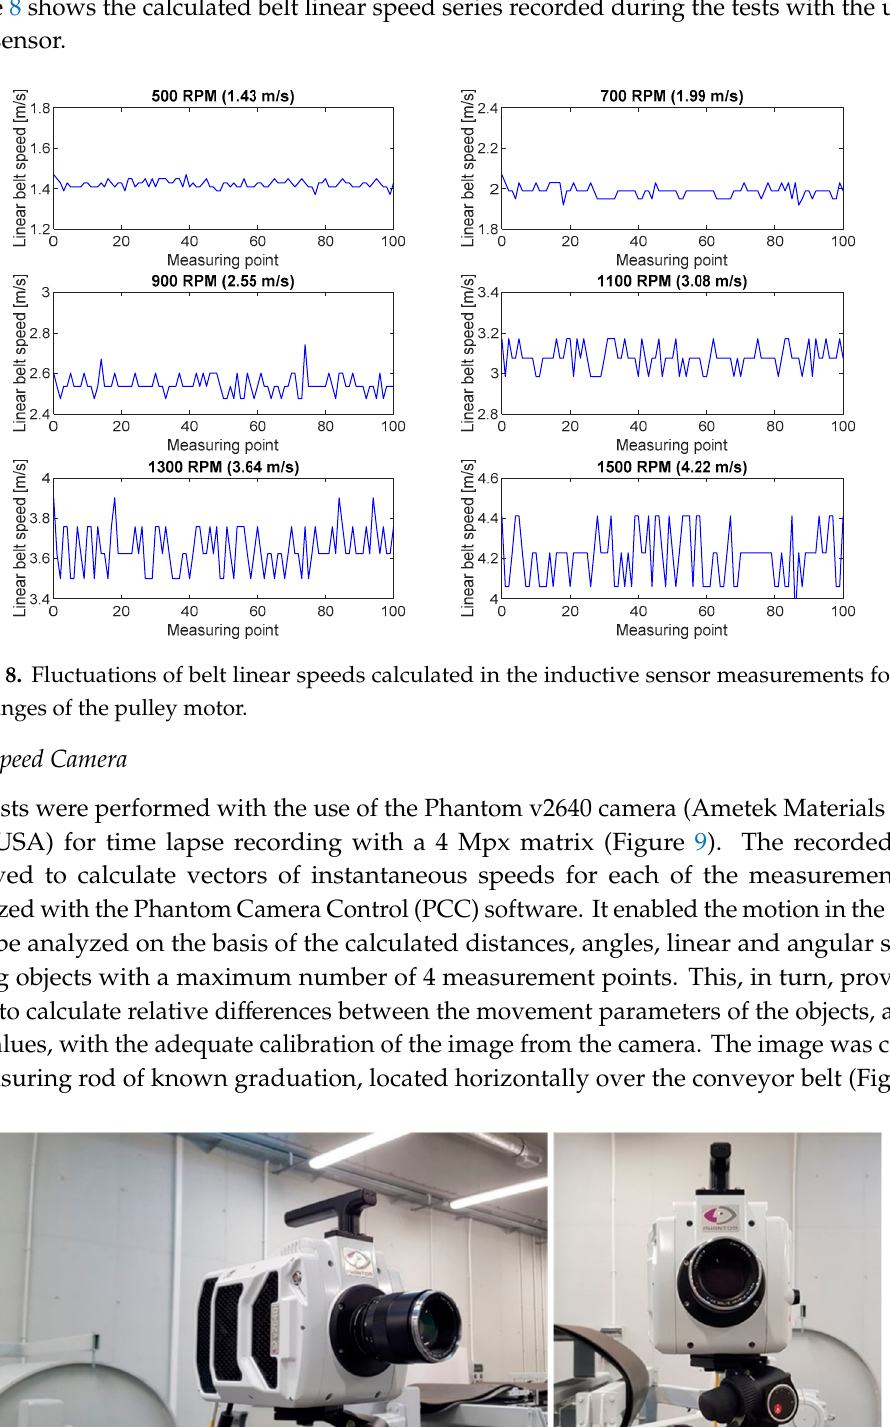
Figure 9. View of the Phantom v2640 camera at the measurement location.